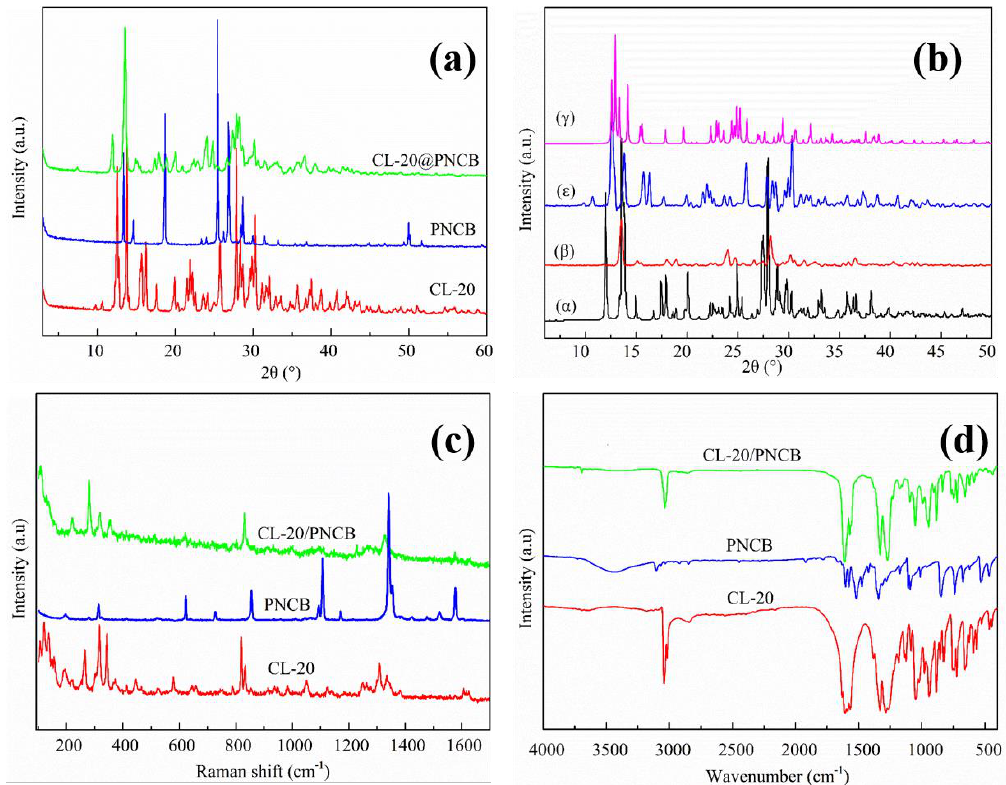
Figure 3. Structural characterization: ( a ) PXRD spectra for raw CL-20, raw PNCB, and the CL-20/PNCB composite. ( b ) PXRD spectra for α -CL-20, β -CL-20, ε -CL-20, and γ -CL-20. ( c ) Raman spectra for raw CL-20, raw PNCB, and the CL-20/PNCB composite. ( d ) FT-IR spectra for raw CL-20, raw